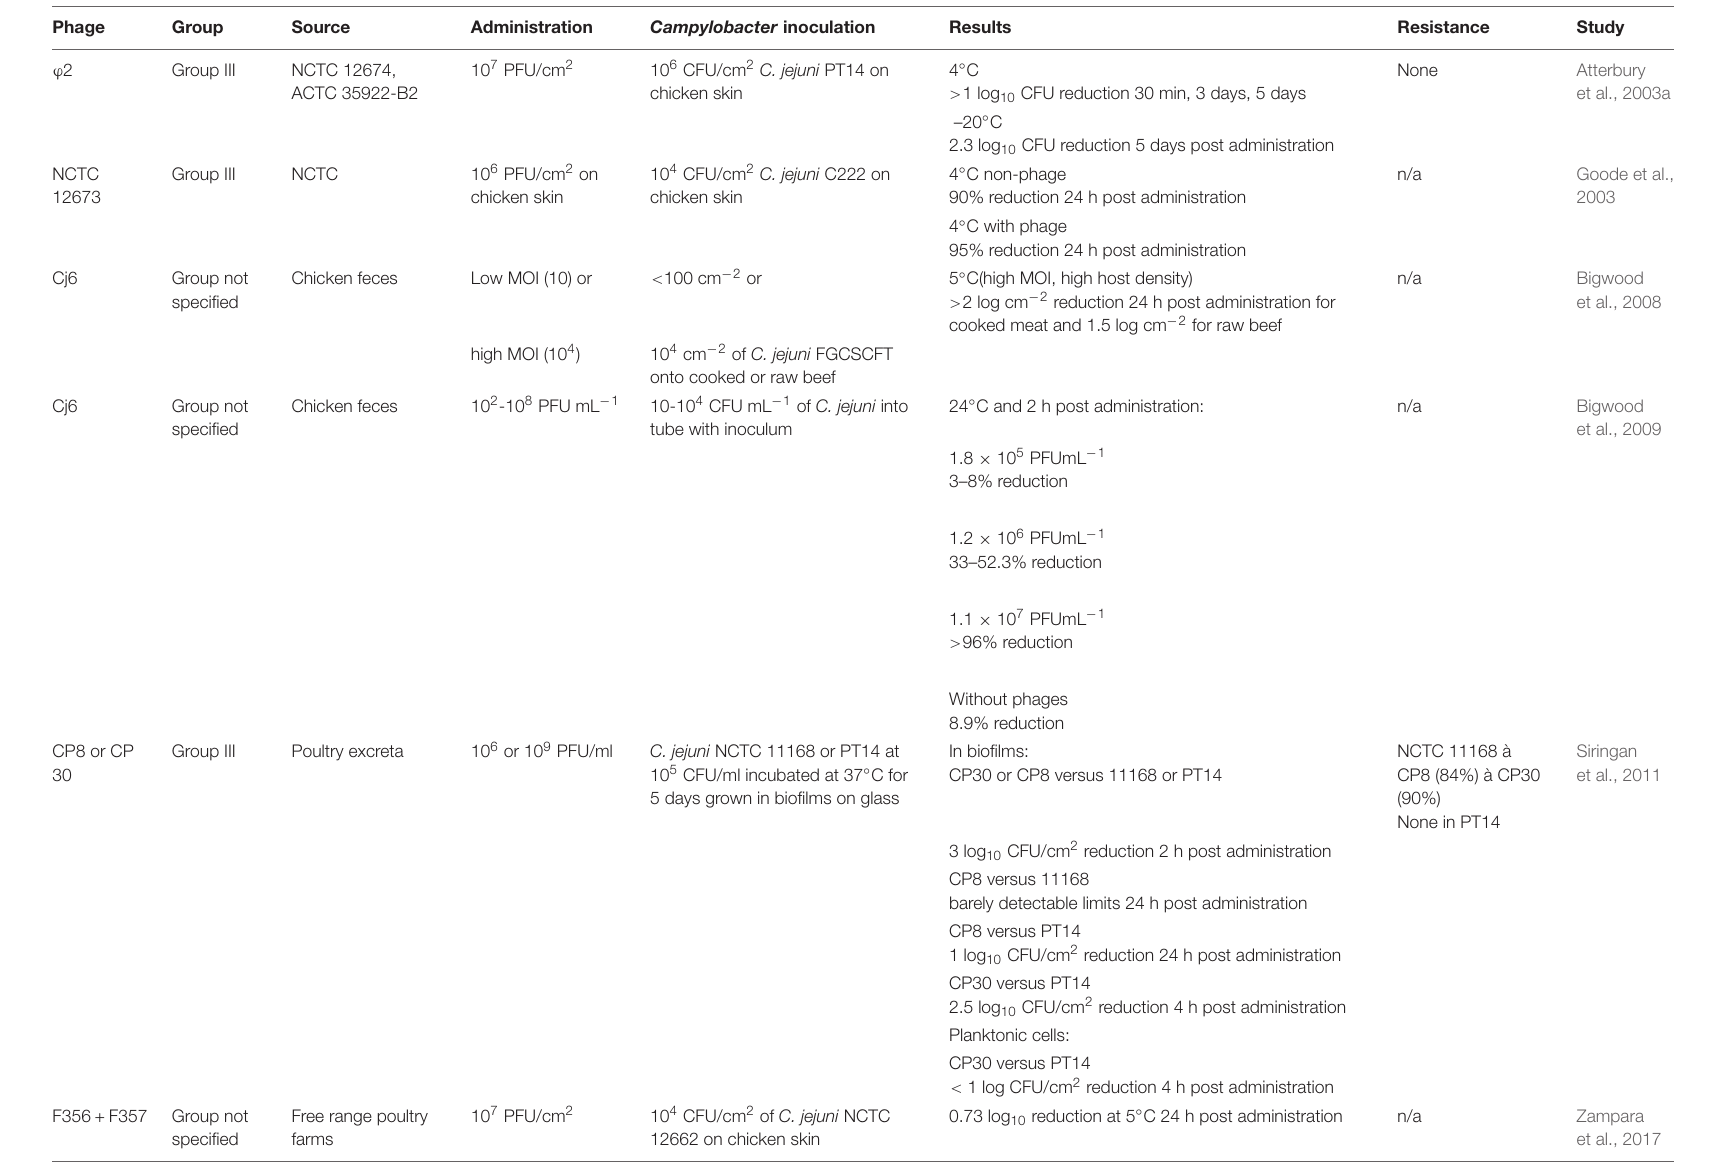
TABLE 3 | Campylobacter phage treatments during the postharvest